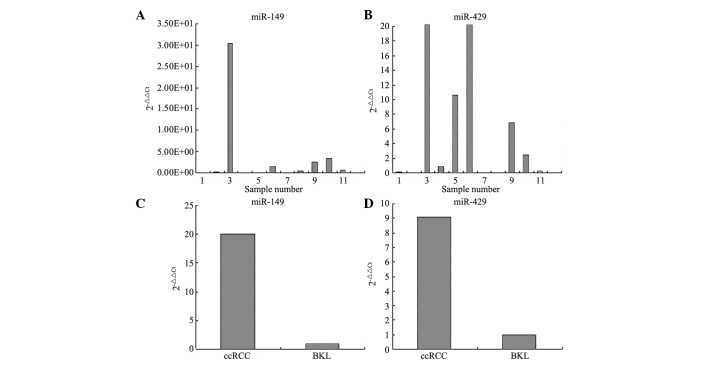
Individual (A, B) and general (C, D) relative quantification for miR-149 and miR-429 in serum samples from patients with ccRCC compared with those with BKL. ccRCC, clear cell renal cell carcinoma; BKL, benign kidney lesion.